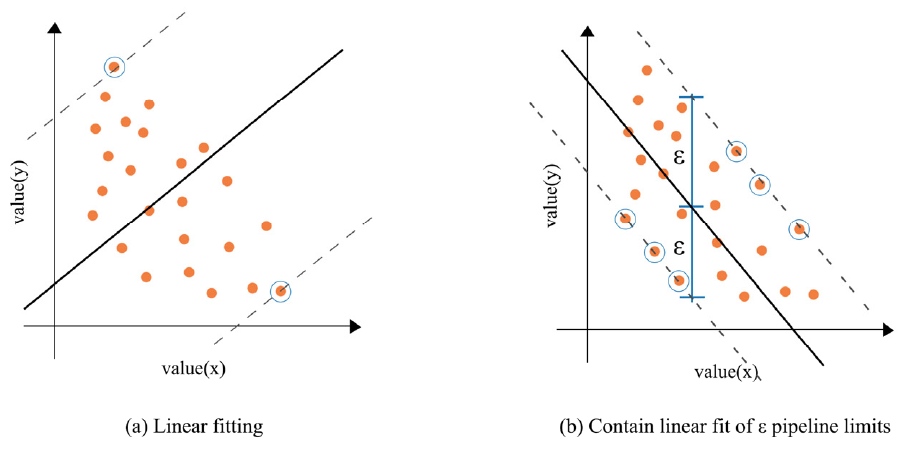
Figure 7. SVR linear fitting schematic.